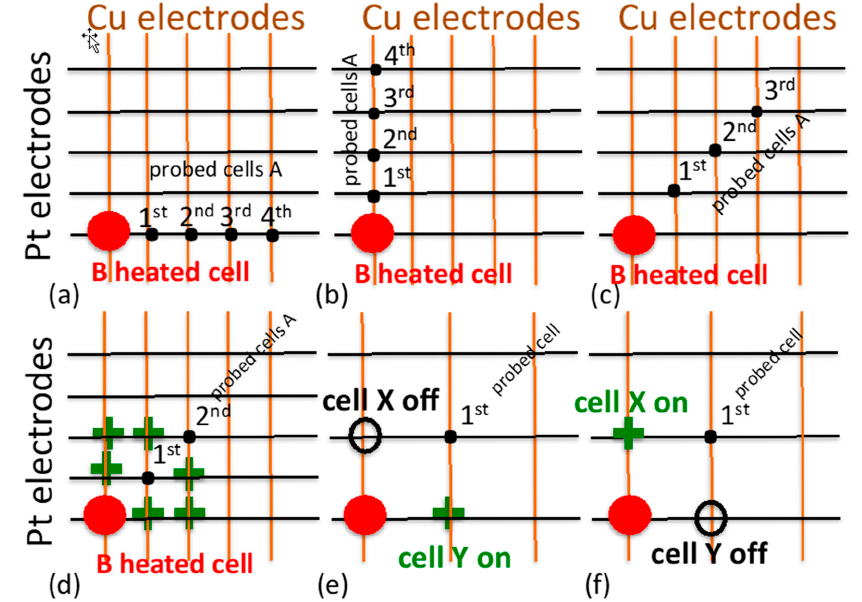
Figure 3. Location of neighbor cells relative to the heated cell marked by a red dot. Initially, the cells are set in an off ‐ state. ( a ) Heat transport from the heated cell to its neighbors located on the Pt electrode. ( b ) Heat transport to its neighbors disposed along the Cu electrode. ( c ) Heat transport to its neighbors located diagonally with respect to the heated cell. ( d ) Heat transport to its neighbors at diagonal locations with intermediate cells (marked by green crosses) in the on ‐ state. ( e ) Thermal path from the heated cell to first cell via cell Y. ( f ) Thermal path from the heated cell to first cell via cell X.